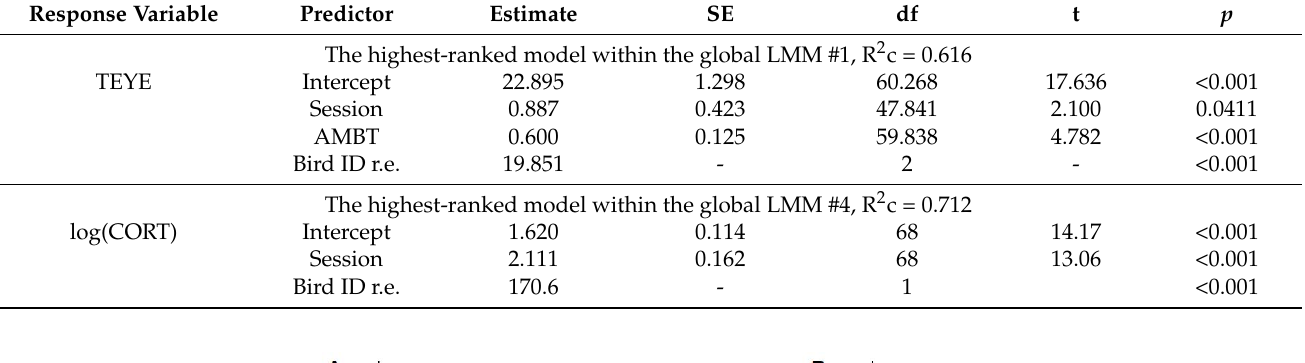
Table 2. The highest-ranked LMMs with combinations of predictors included in the global models listed in Table 1 estimating the effects of various predictors on eye region temperature (TEYE) and corticosterone level (CORT) in Little Auks in capture-restraint experiment. Predictors: Session (first representing handling stress-induced TEYE and baseline CORT, and the second representing restrain- induced TEYE and acute stress-induced CORT), AMBT—ambient air temperature, Bird ID r.e.—bird identity (random effect). Significance of a random effect, the bird identity (Bird ID) estimated by F-test with Kenward–Roger approximation. R 2 c—conditional R squared—a variance explained by the entire model, including both fixed and random effects [45], df – degrees of freedom.